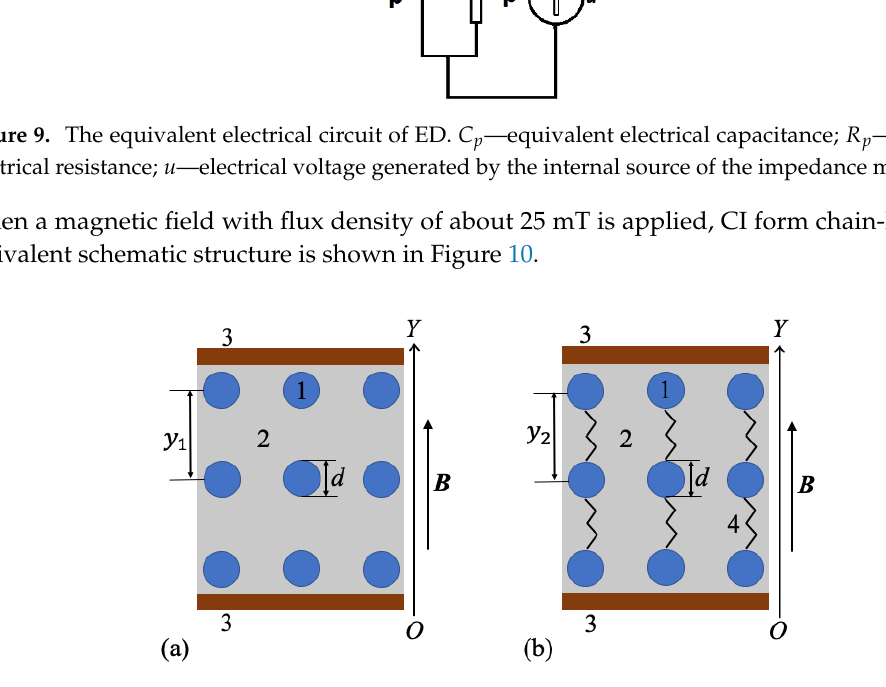
Figure 10. Model of magnetic dipoles in hMCs. ( a ): without µ F. ( b ): with µ F. 1—magnetic dipoles; 2—GB with SO; copper electrode; 4— µ F; d —average diameter of a magnetic dipole; y 1 and y 2 —distances between center-of-masses of two neighboring magnetic dipoles; B —magnetic flux density vector; OY —coordinate